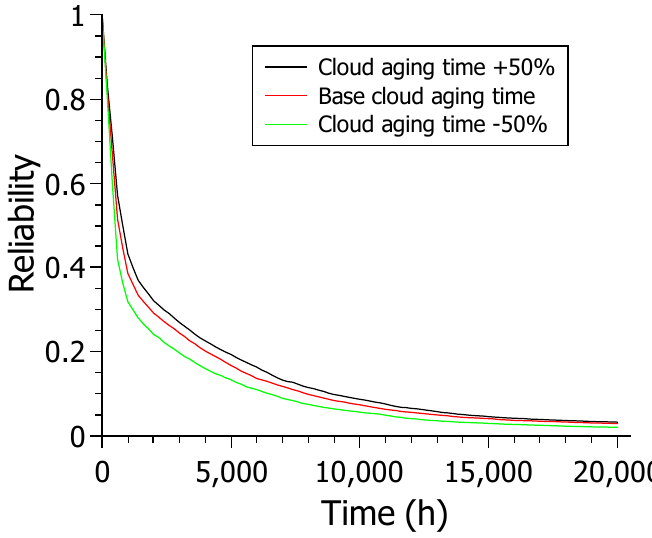
Figure 13. Reliability results varying the CS_AGING parameter in model